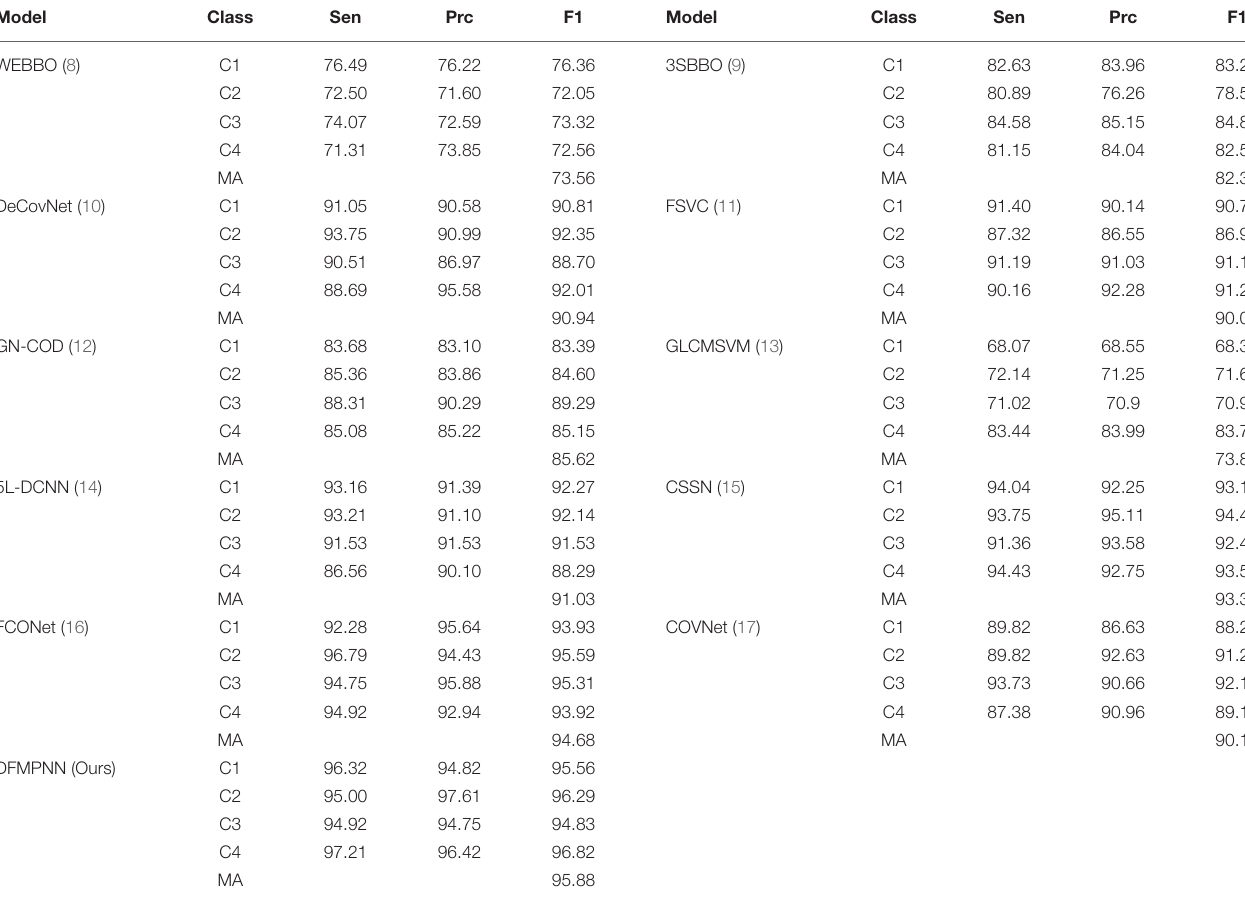
TABLE 9 | Comparison with state-of-the-art